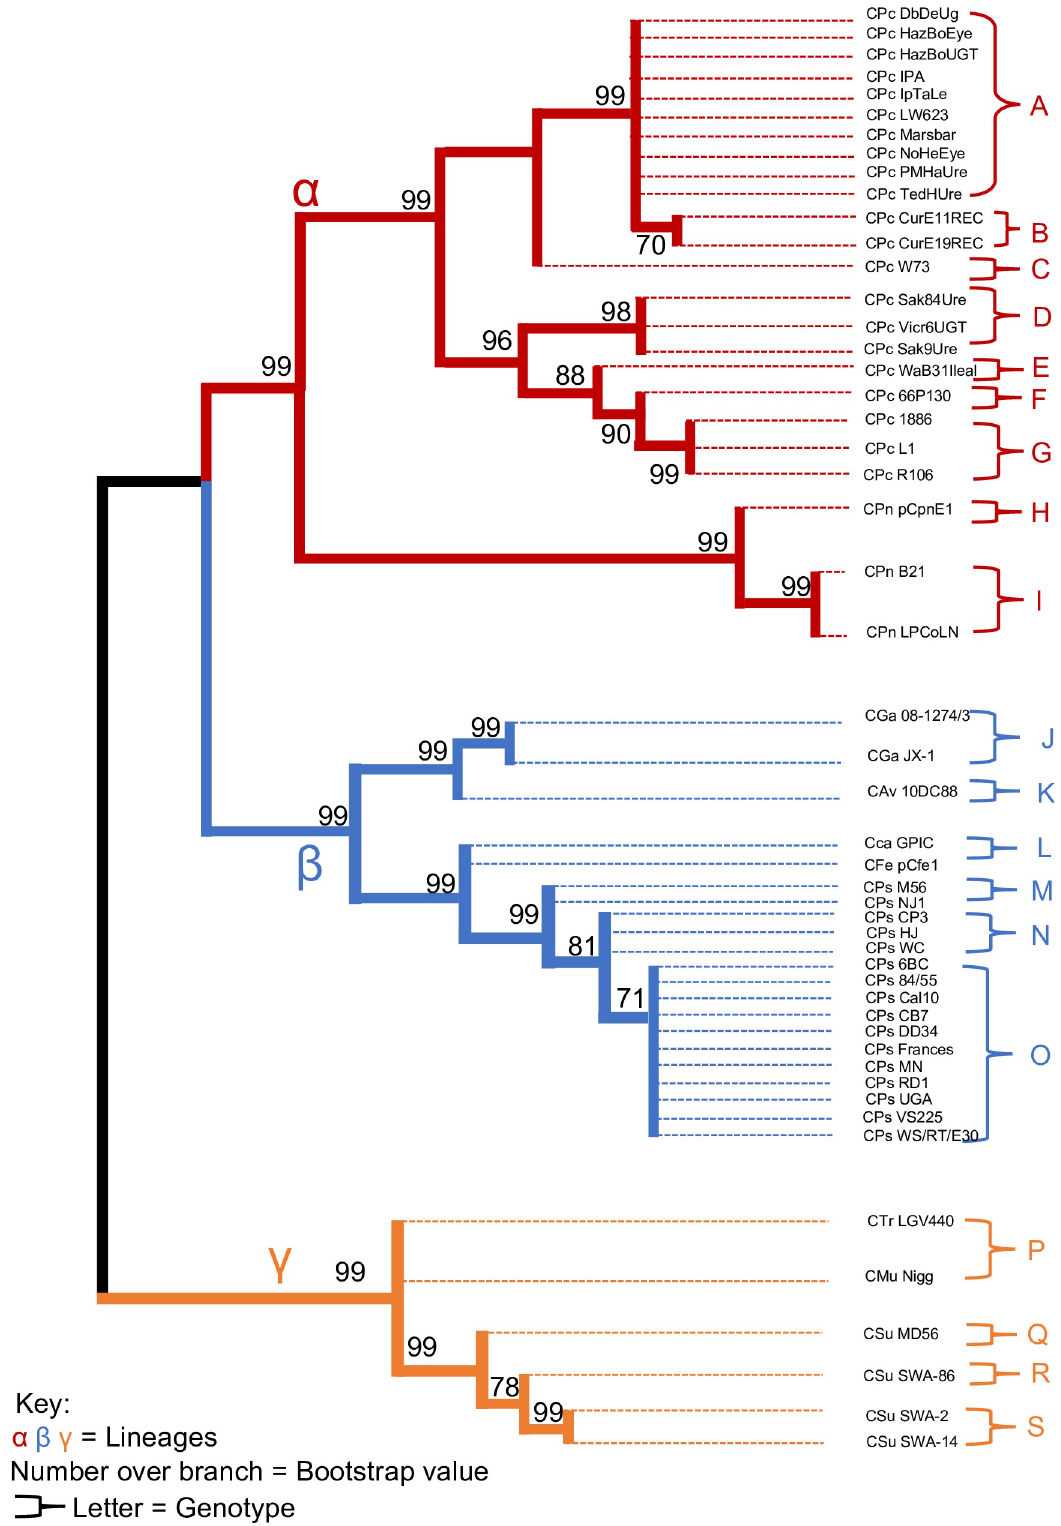
Fig 2. Maximum Likelihood estimate phylogeny for 51 Chlamydial plasmids with a log likelihood of log(-60175.44).